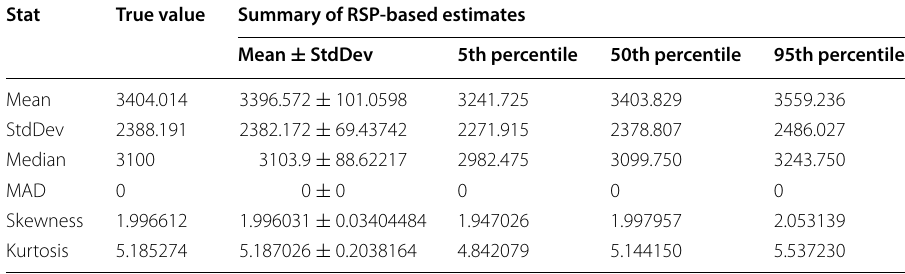
RSP-based estimates were calculated from a sample of clean RSP blocks ( g = 100 )